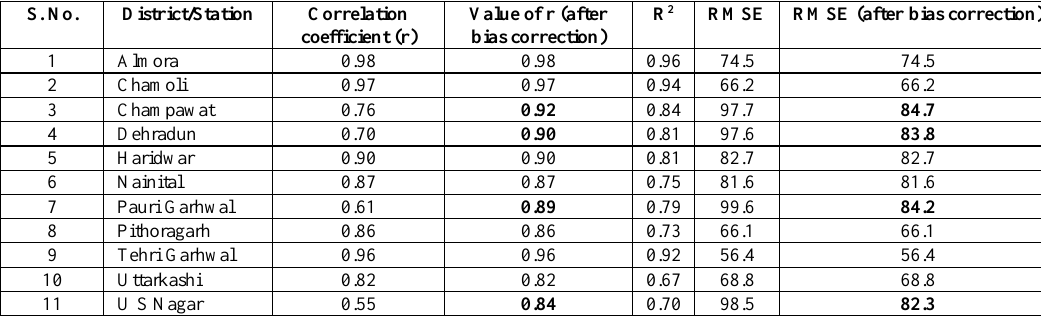
Table 3. Improved performance evaluation of ANN